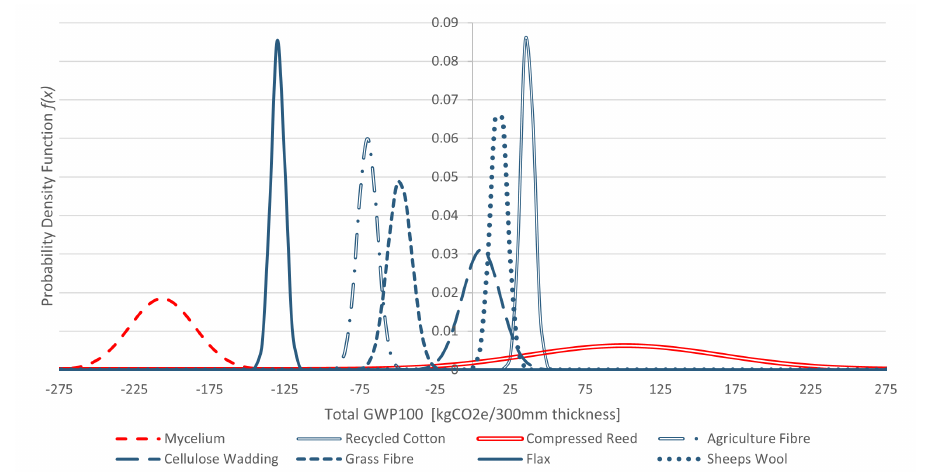
Table 3. Expected SLCA GWP 1 00 ranges and required thickness for thermal resistance of 6.3 m tions, are presented in Figure 1 for each